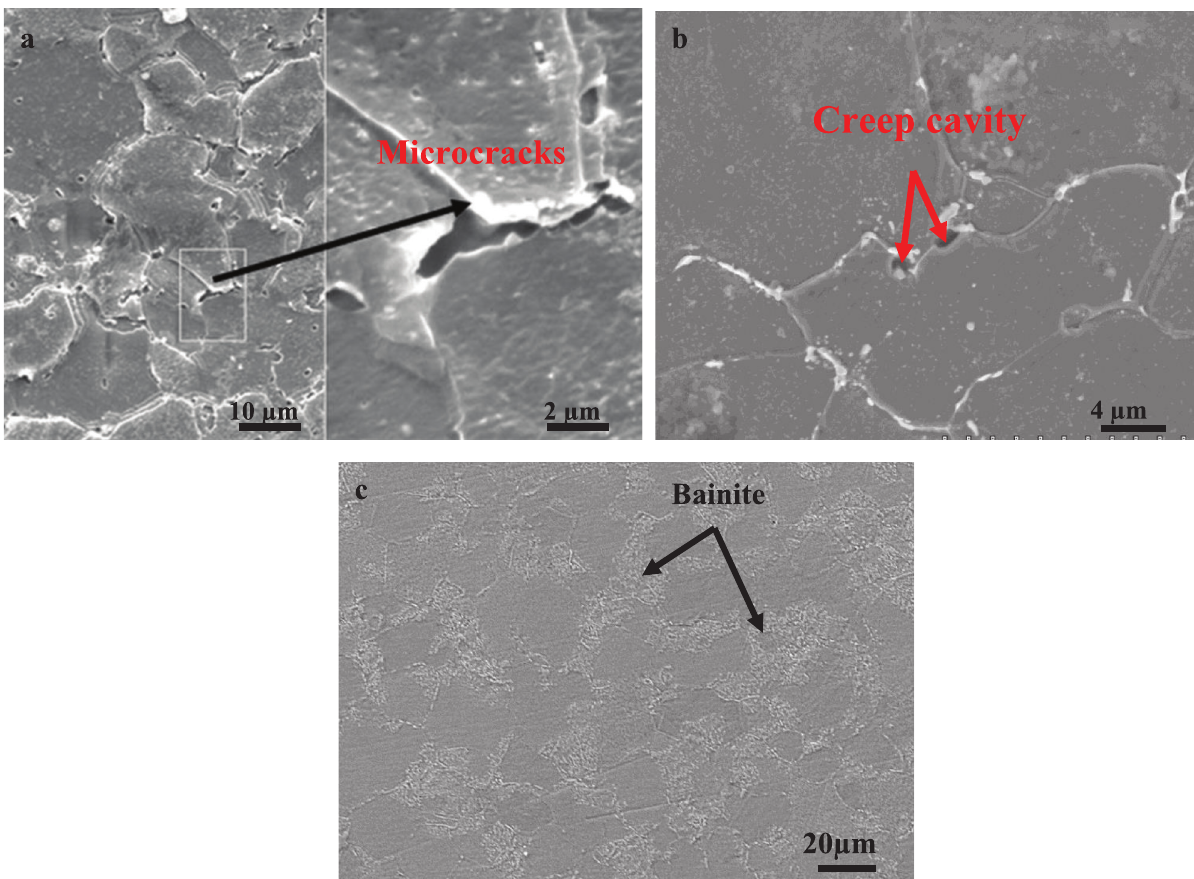
Fig. 5: Microstructure (a) near fracture surface of failed tube showing intergranular microcraks at the grain boundaries (b) away from the failure zone showing isolated creep cavities at the grain boundaries and (c) new unused tube showing banite and ferrite